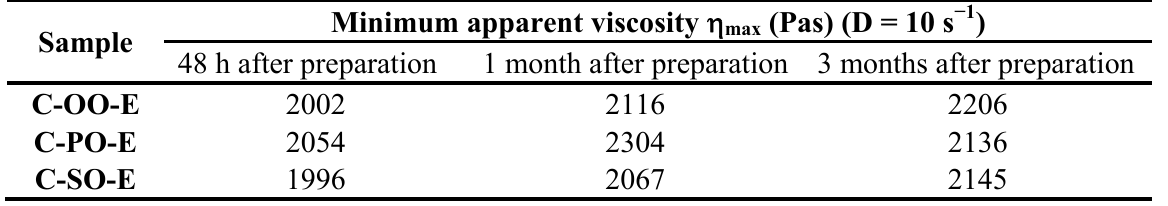
Table 4. Rheological characteristics/ samples stored at 5 ± 2